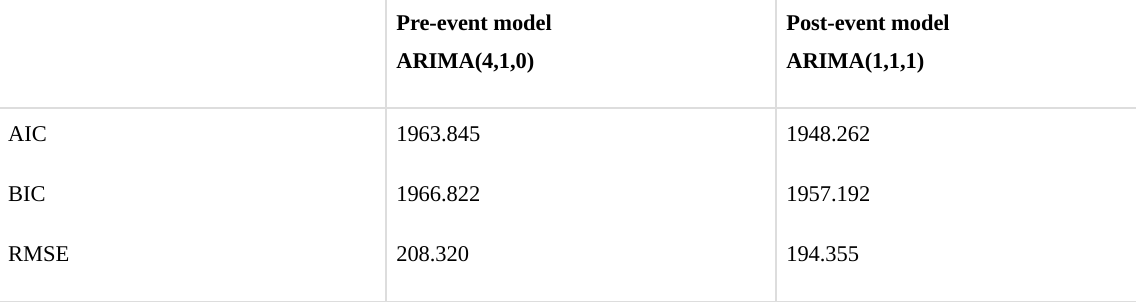
Table A4b. Goodness of fit measures of ARIMA models for border restrictions.